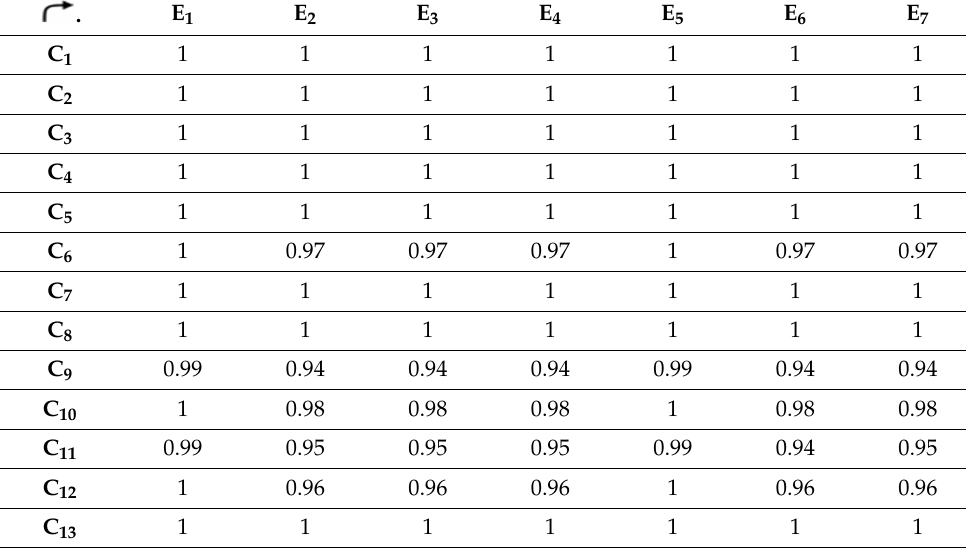
Table 10. Maximum–minimum convolution between matrices (cumulative effects) [ (cid:101) M .